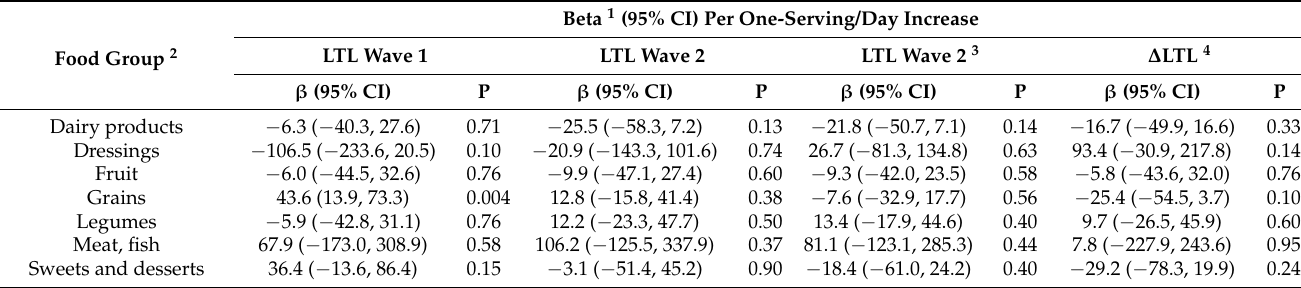
Table 4. Joint association analysis of individual food groups (loadings at least 0.3 in absolute value with Factor 1). Beta estimates and 95% confidence intervals (CI) for telomere length (base-pairs) from waves 1 and 2.